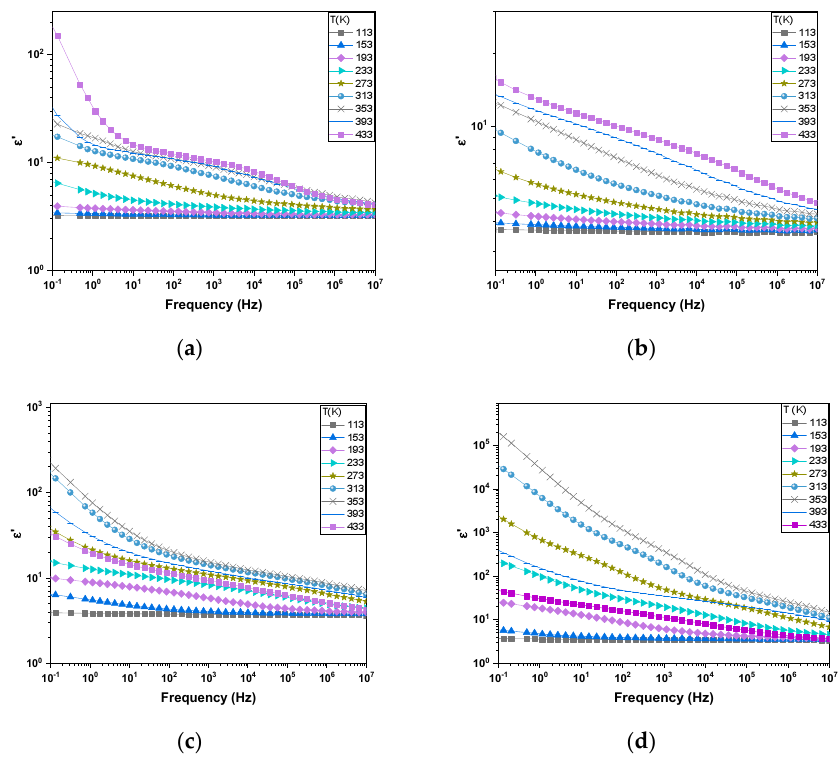
Figure 6. Variations in real part of permittivity with frequency at different temperatures for ( a ) PPDA and PPDA/MMT composites: ( b ) PPDA − 5, ( c ) PPDA − 35 and ( d ) PPDA − 50.